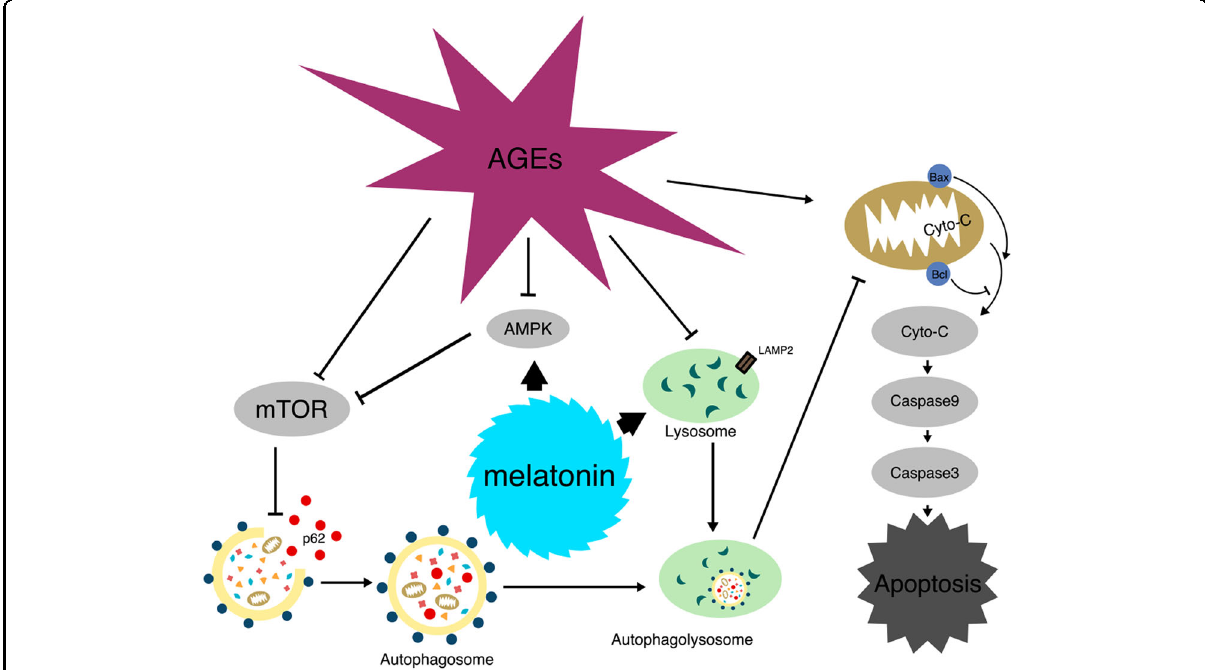
Fig. 8 Schematic model of the signaling mechanisms underlying the bene fi cial effects of melatonin on AGE-induced apoptosis of